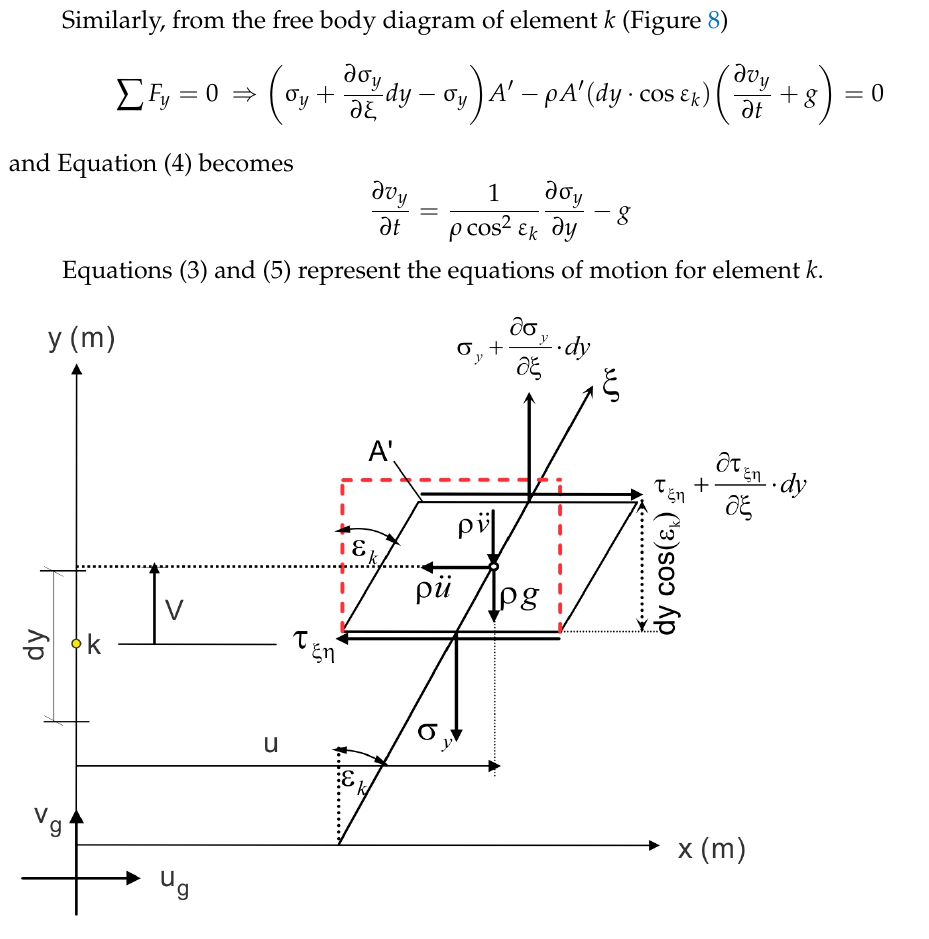
Figure 8. The free body diagram of element k